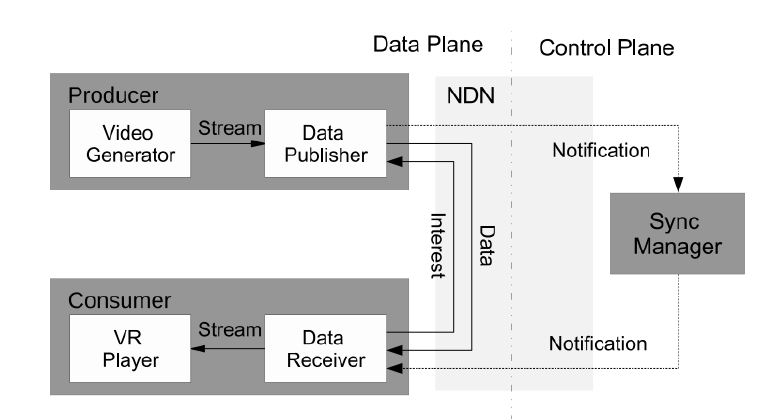
Figure 3. Framework of the named data networking (NDN) virtual reality (VR) conferencing